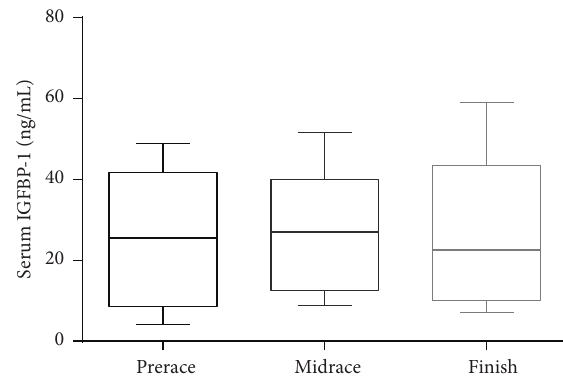
Figure 2: IGFBP-1 at prerace, midrace, and race finish. Boxes repre- sent mean and 75th and 25th percentiles and whiskers represent 1st and 99th percentiles.